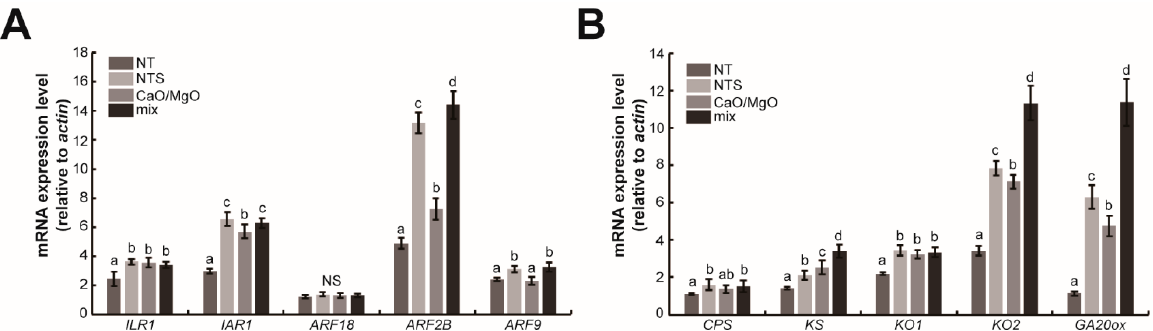
Figure 2. Changes in the expression of auxin biosynthesis/response genes ( A ) and GA biosynthesis genes ( B ) in leaf lettuce leaves treated with NTS, CaO/MgO, and mixed treatment. NT, nontreatment group; NTS, NTS treatment group; CaO/MgO, CaO/MgO treatment group; mix, mixed (NTS, CaO, and MgO) treatment group. All experiments were repeated three times, and the error bars indicate standard deviation ( n = 9). Different letters above bars indicate statistically significant differences as determined by one-way ANOVA ( p < 0.05).